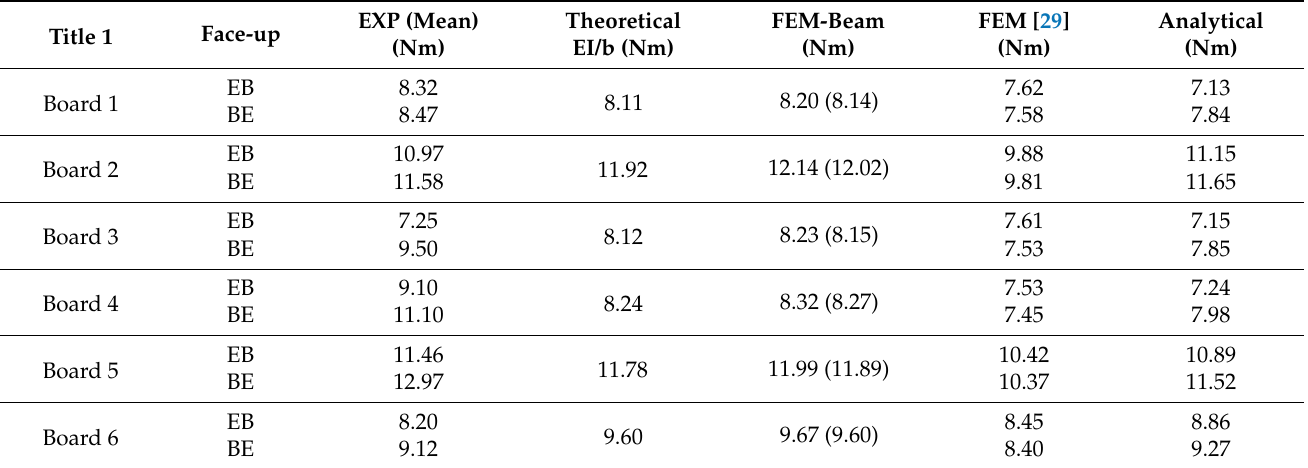
Table 5. BS for all considered models. The values in parentheses represent BS calculated using the FEM-Beam model without taking into account both corrugated layers.